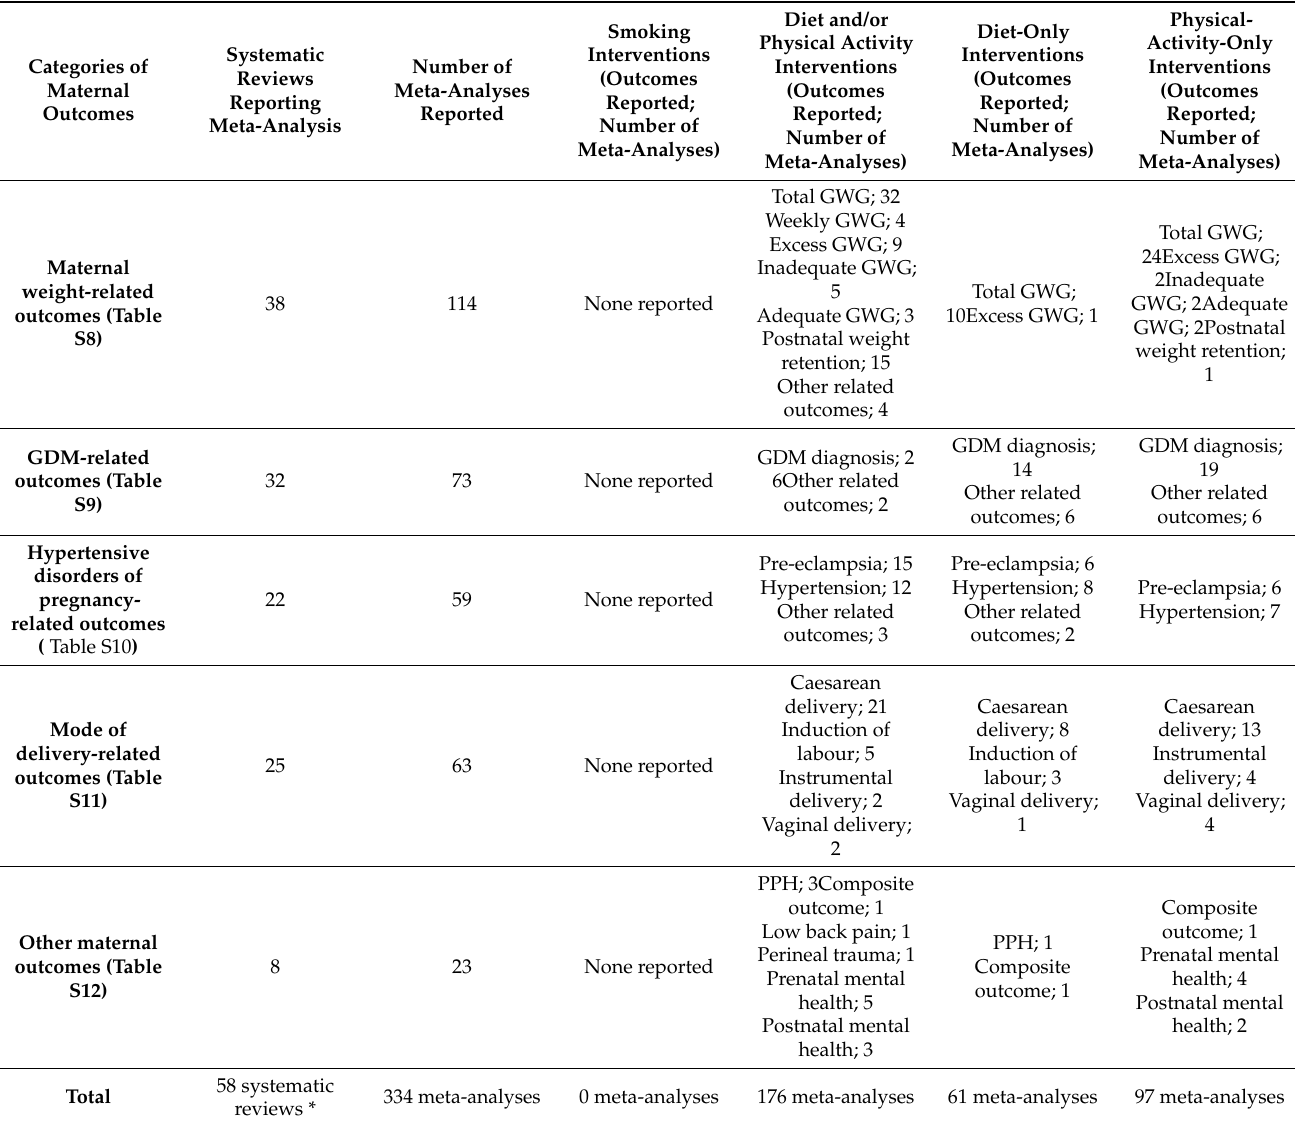
Table 3. Summary of meta-analysis of maternal health outcomes reported by the included systematic reviews.